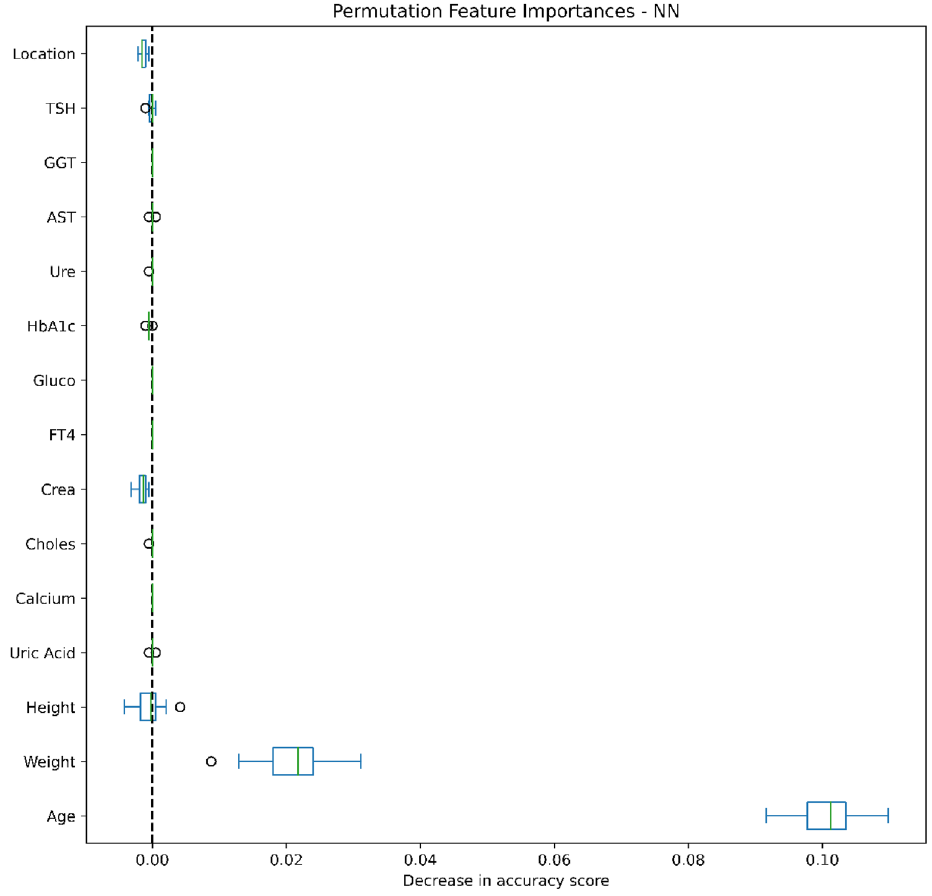
Figure 11. Feature importance for NN in the second scenario.